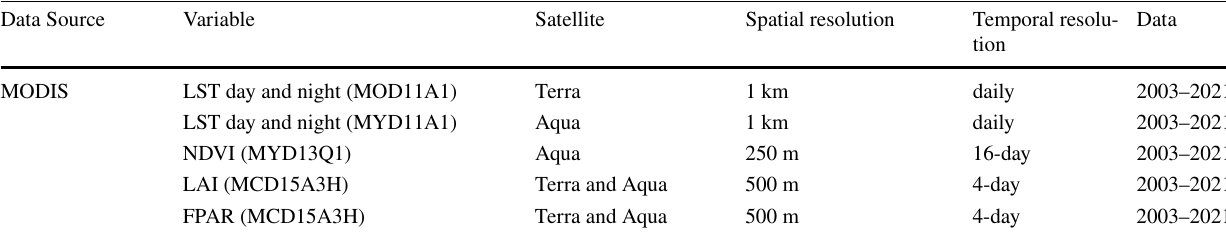
Table 2 Remote sensing data